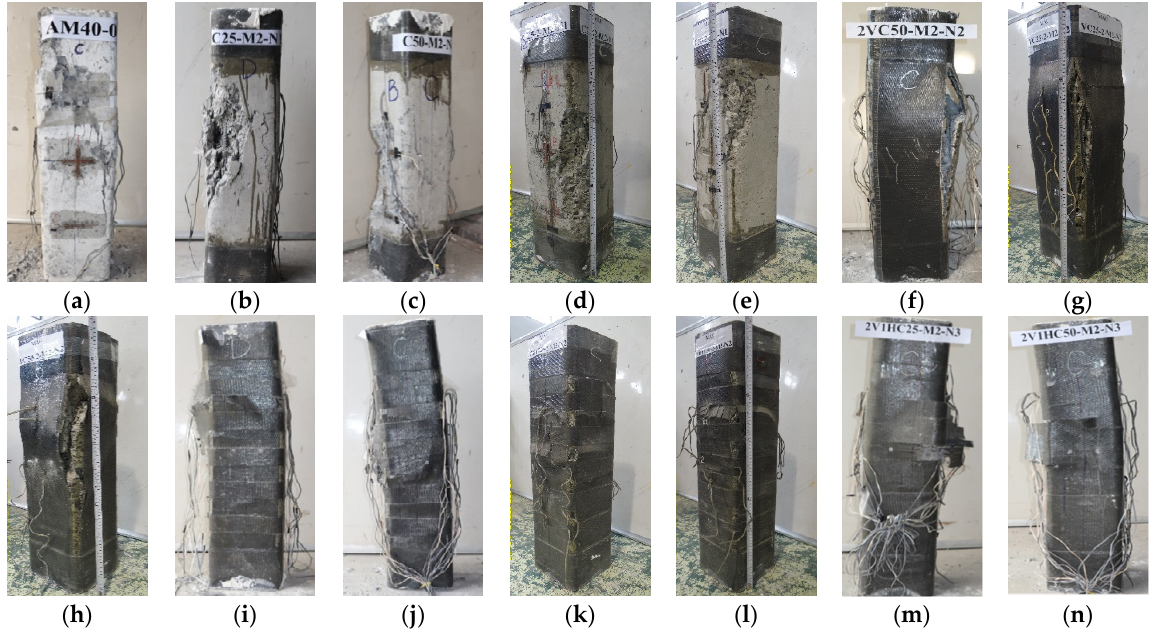
Figure 8. Failure modes of the tested columns; ( a ) 00-00; ( b ) 00-25; ( c ) 00-50; ( d ) 00-2525; ( e ) 00-5050; ( f ) 10C50; ( g ) 10C2525; ( h ) 10C5050; ( i ) 1iC25; ( j ) 1iC50; ( k ) 1iC2525; ( l ) 1iC5050; ( m ) 11C25; ( n ) 11C50.